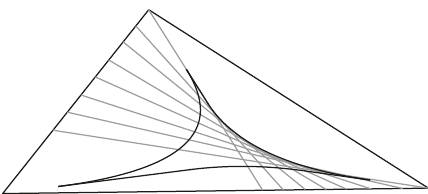
Figure 1: Every line tangent to the perimeter-bisecting deltoid bisects the perimeter of the triangle.